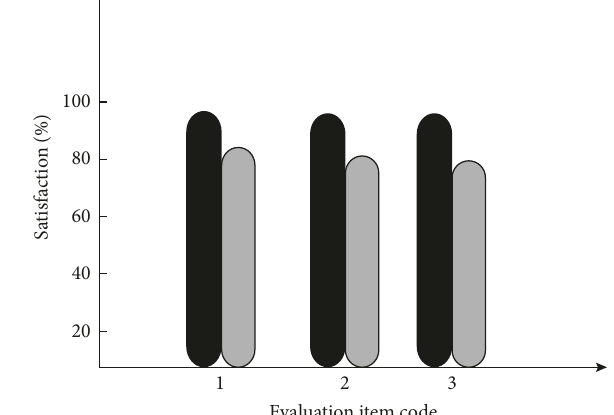
Figure 5: Satisfaction degree after using the proposed teaching model.